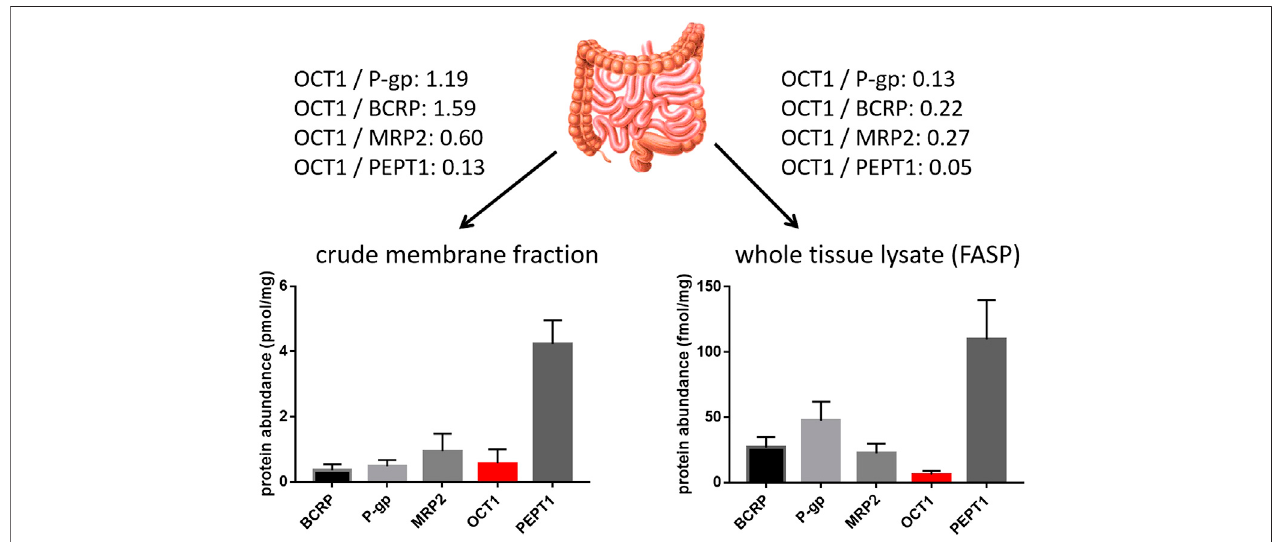
FIGURE 2 | Impact of sample preparation on the observed protein abundance of relevant intestinal transporter proteins in the human jejunum. Data on the left diagram were observed from six organ donors after isolation and targeted proteomics analysis of the crude membrane fration (Drozdzik et al., 2014), while data on the rightdiagramwereobservedfromnineorgandonorsaftersamplepreparationusingtheFASP( fi lteraidedsamplepreparation)protocolandtargetedproteomicsanalysis of the resulting whole tissue lysates. Relative expression ratios of OCT1 to the other transporters are given.